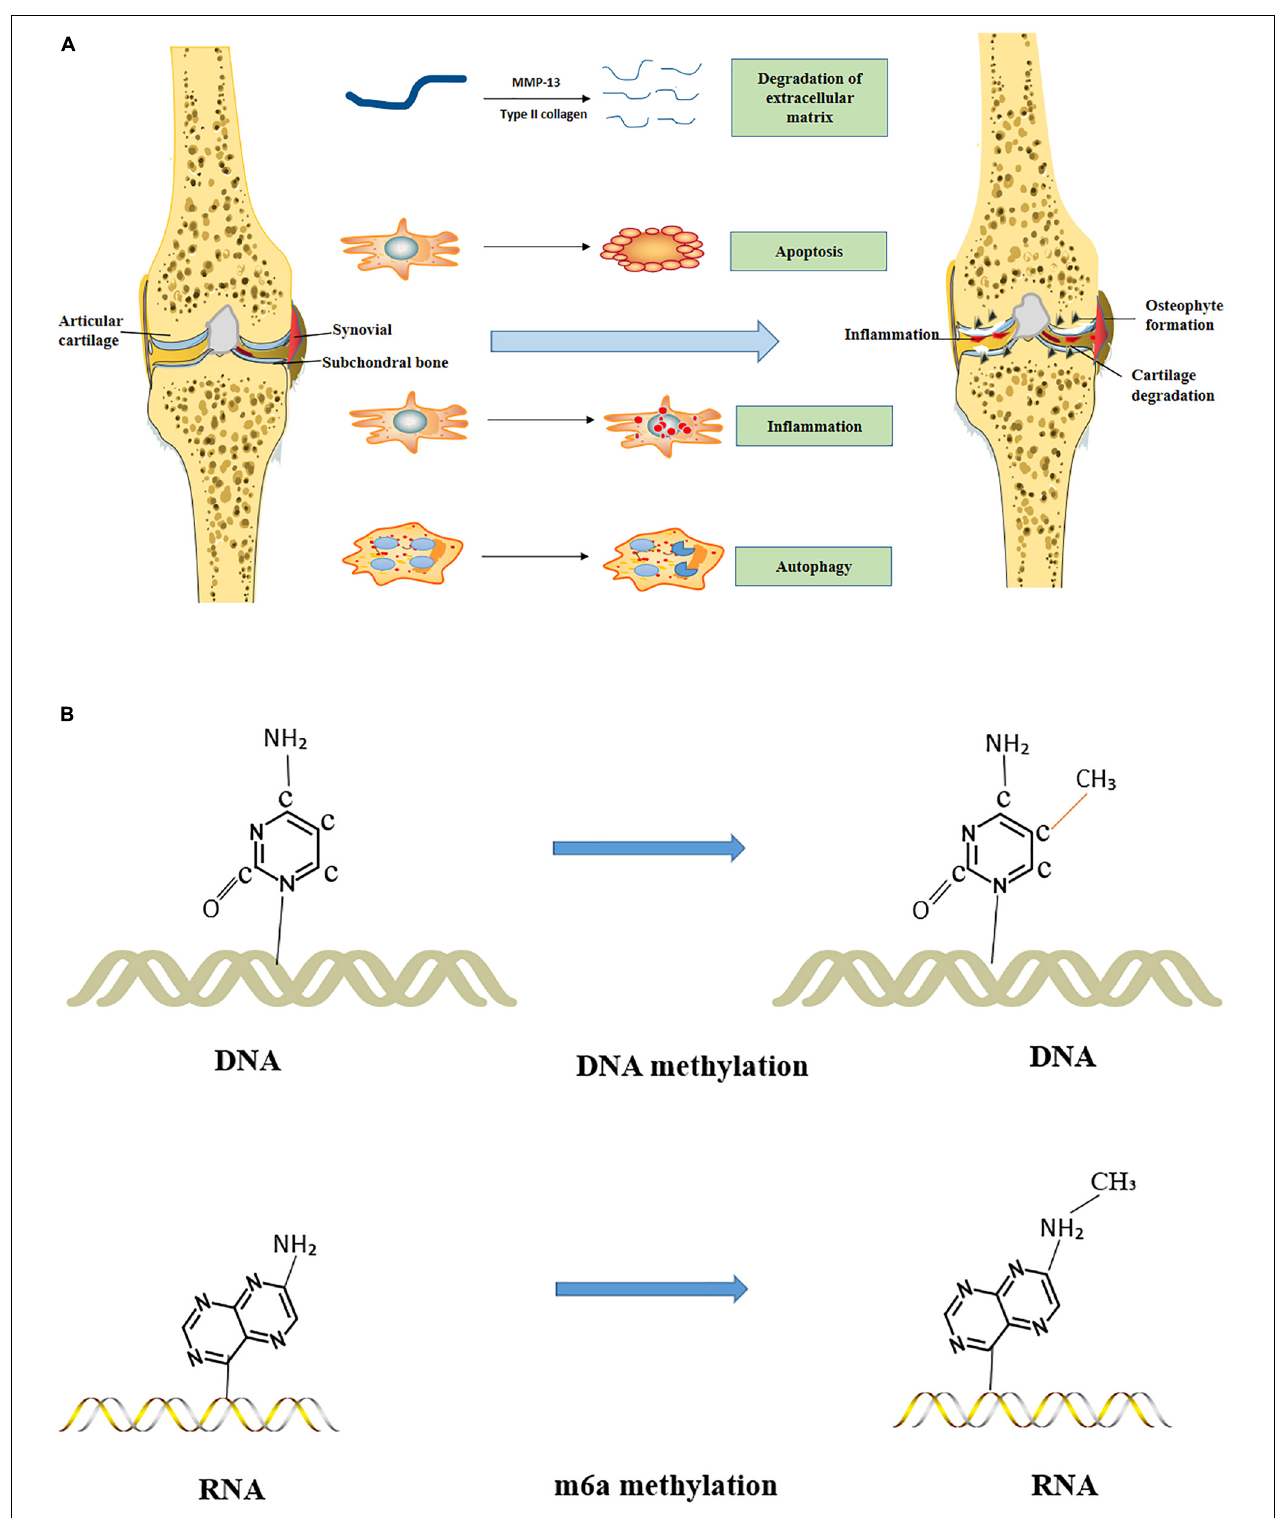
FIGURE 1 | Pathogenesis of Osteoarthritis (OA). (A) The degradation of ECM, apoptosis, inflammatory response, and autophagy mechanisms in OA. (B) Methylation in OA.